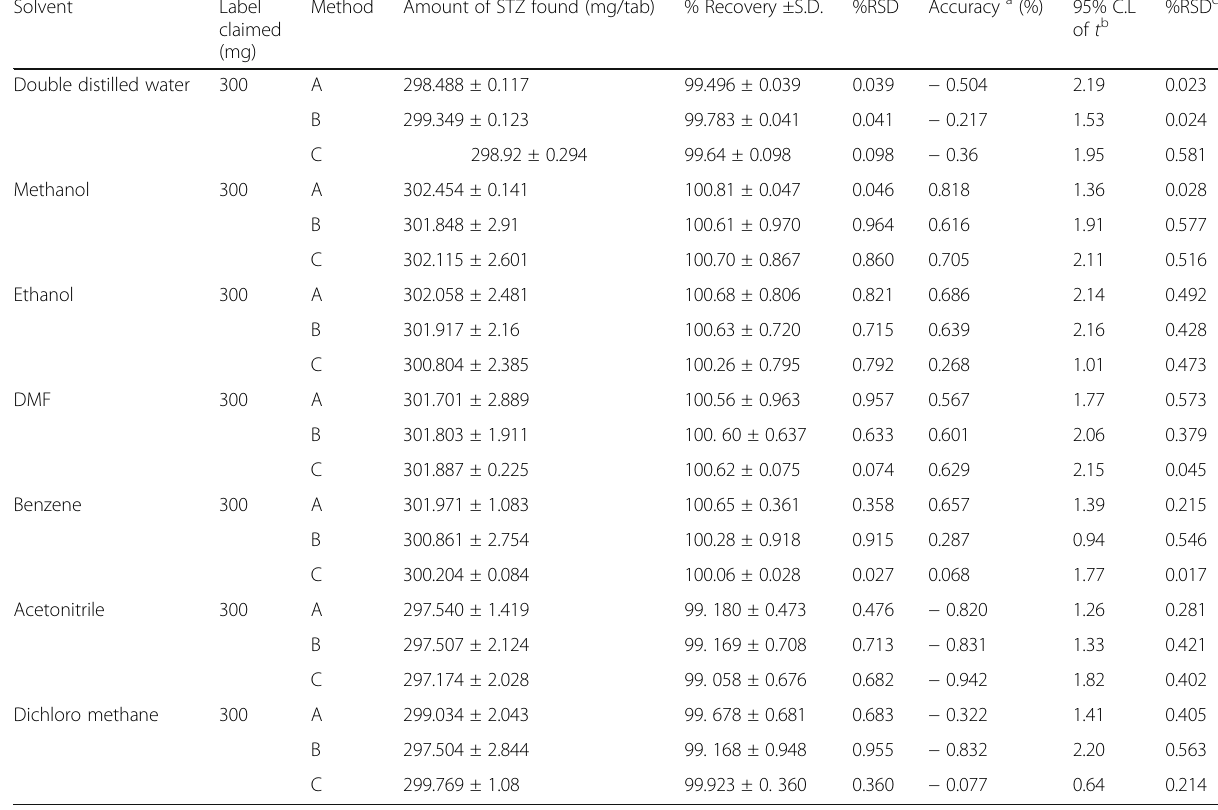
Table 5 Determination of satranidazole (STZ) from pharmaceutical product by spectrophotometric method Solvent